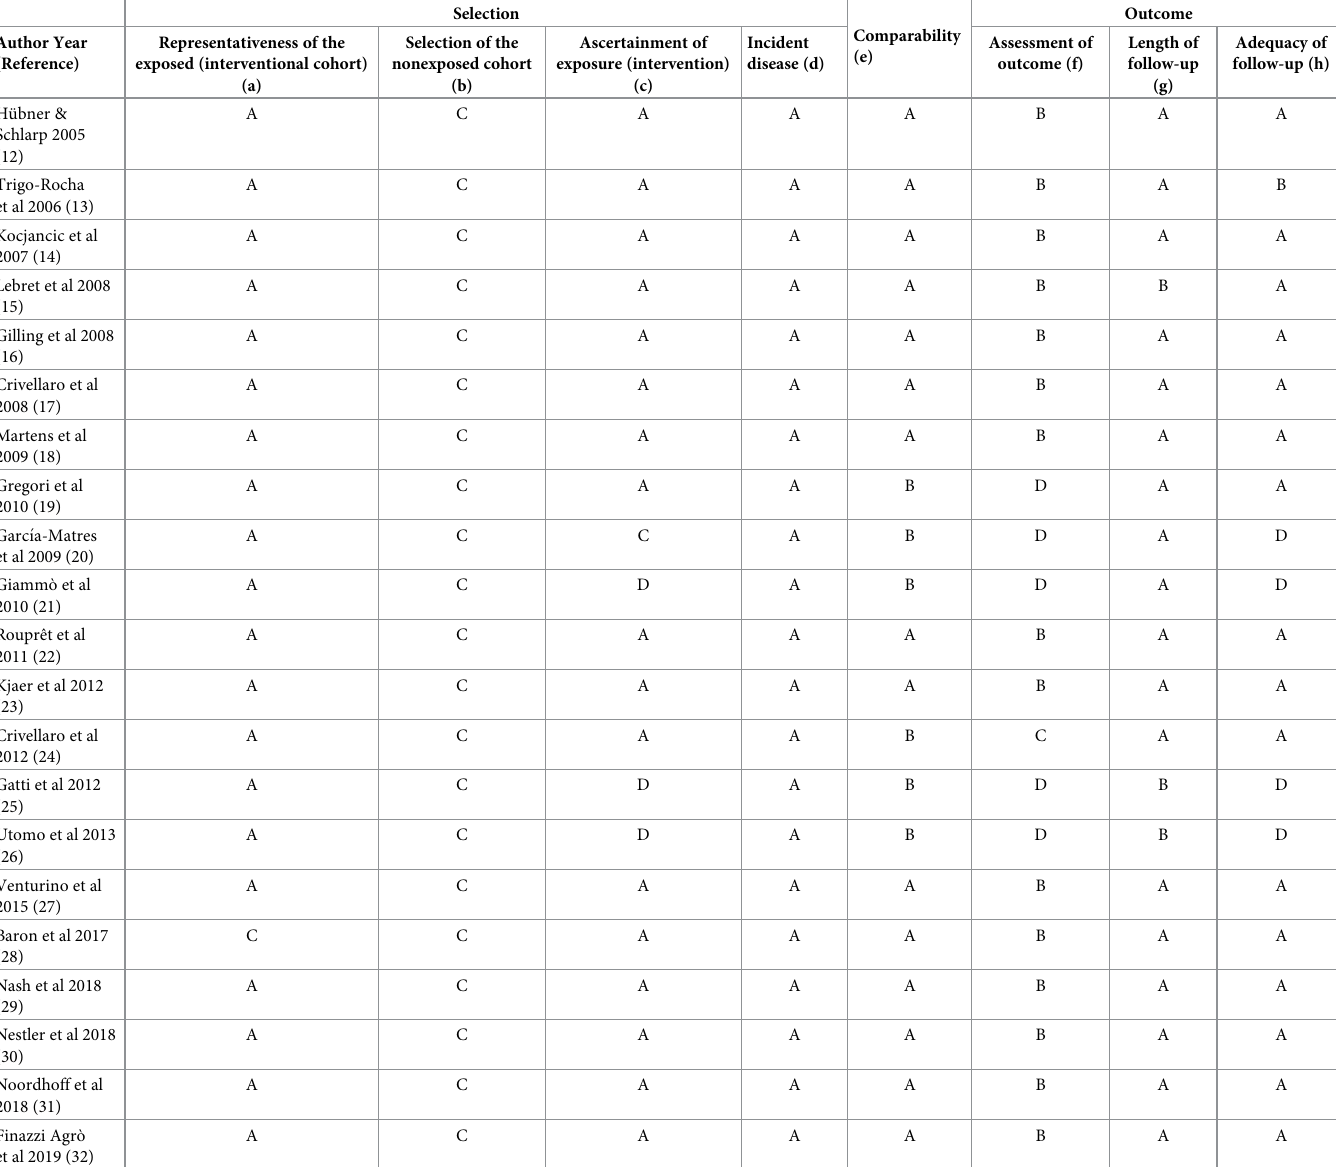
Table 4. Newcastle-Ottawa scale for assessing the quality of cohort studies with ProACT included in the